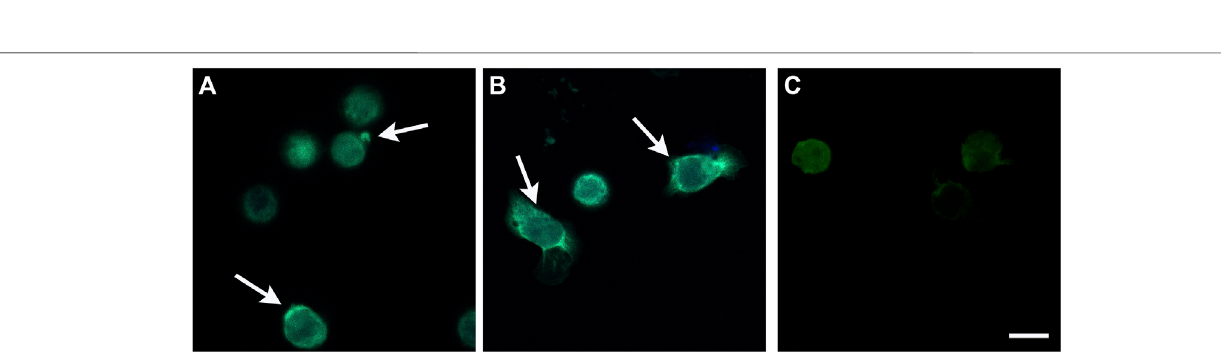
FIGURE3| StimulationofCellularLocomotionandEndocytosisbyAlphataxin.U937Clone10cellswerepreconditionedwith α 1PI,Alphataxin,orbufferat37 ° Cfor 15 min to induce polarization and receptor aggregation followed by incubation with SHIV at either 2 ° C or 37 ° C for 2 h. Cells were adhered to Alcian blue-coated slides and imaged by epi fl uorescence microscopy using a Zeiss Axioplan. Representative images were captured by confocal microscopy with a Perkin Elmer Operetta High Content Imaging System using 2 μ m scanning from the attached surface toward the unattached surface. The three representative confocal images depicted were captured 6 μ m above the attached surface of the cells. (A) Cells maintained at 2 ° C. Arrows denote receptor polarization. SHIV (bright green) was detected only on the exterior plasma membrane of polarized cells, never internal to the cells. (B) Cells maintained at 37 ° C. Arrows denote the leading edge and retracting trailing edge. SHIV (bright green) was detected internal to the cells at the leading edges (green tubes) and in endosomes (green dots) at the trailing edges of migrating cells. (C) Cells preconditioned with buffer alone and maintained at 2 ° C showing no SHIV binding. Bar represents 25 µm. Images are representative of 3 repeated